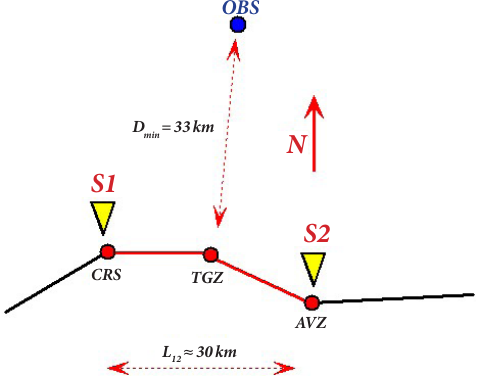
Figure 8. The closest segment to L’Aquila of the Rome–Pescara railway. Here S1 and S2 are the substations, and TGZ is the point of minimum distance from the observatory.